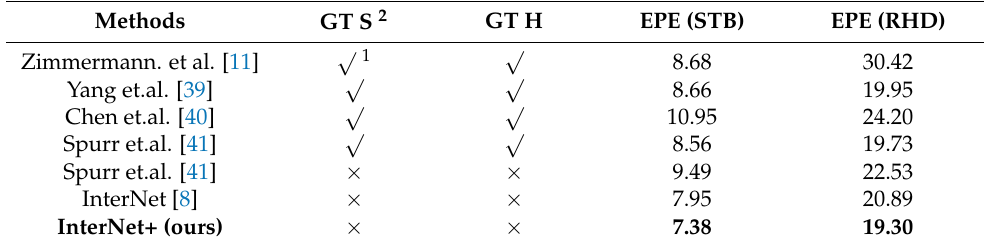
Table 2. Comparison of various methods on the accuracy of hand pose estimation on the STB and RHD